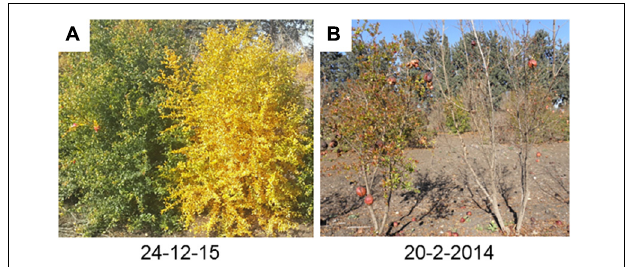
FIGURE 1 | The evergreen and deciduous pomegranate behavior during autumn and winter. Evergreen and deciduous trees from segregating populations were photographed at December (A) and February (B) . The plant at the left (A,B) was an evergreen tree and at right was a deciduous tree.